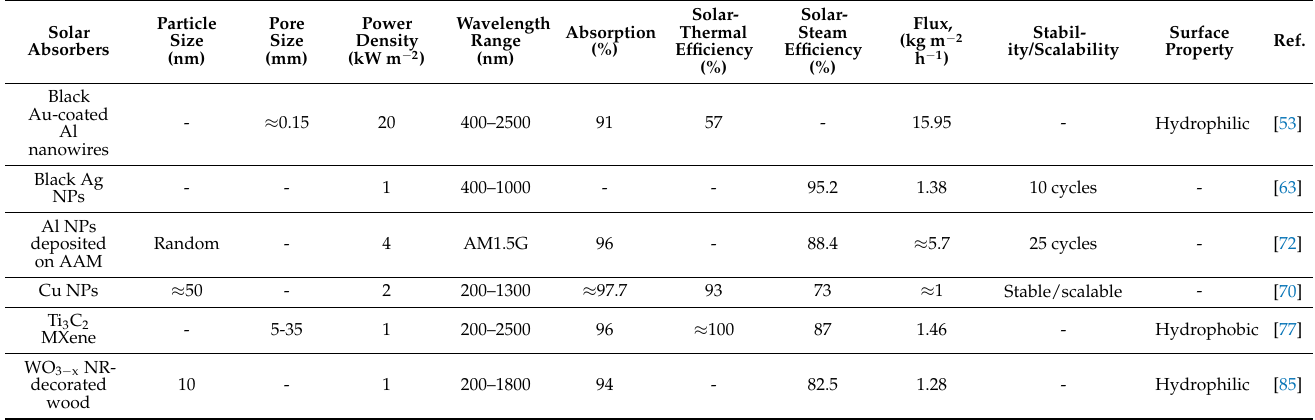
Table 2. Properties, parameters, and performances of plasmonic material-based solar evaporators. Modified from [29]. Reprinted with permission from Ref. [29]. Copyright 2022 Royal Society of